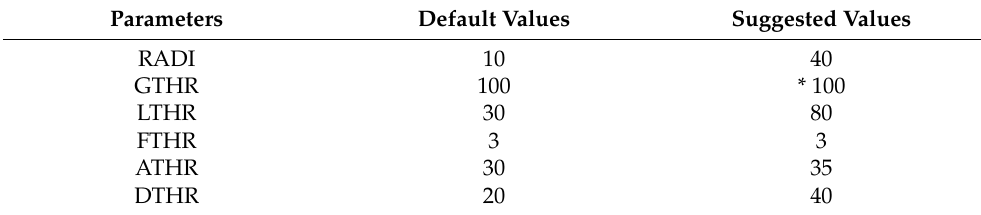
Table 1. Parameters values of LINE